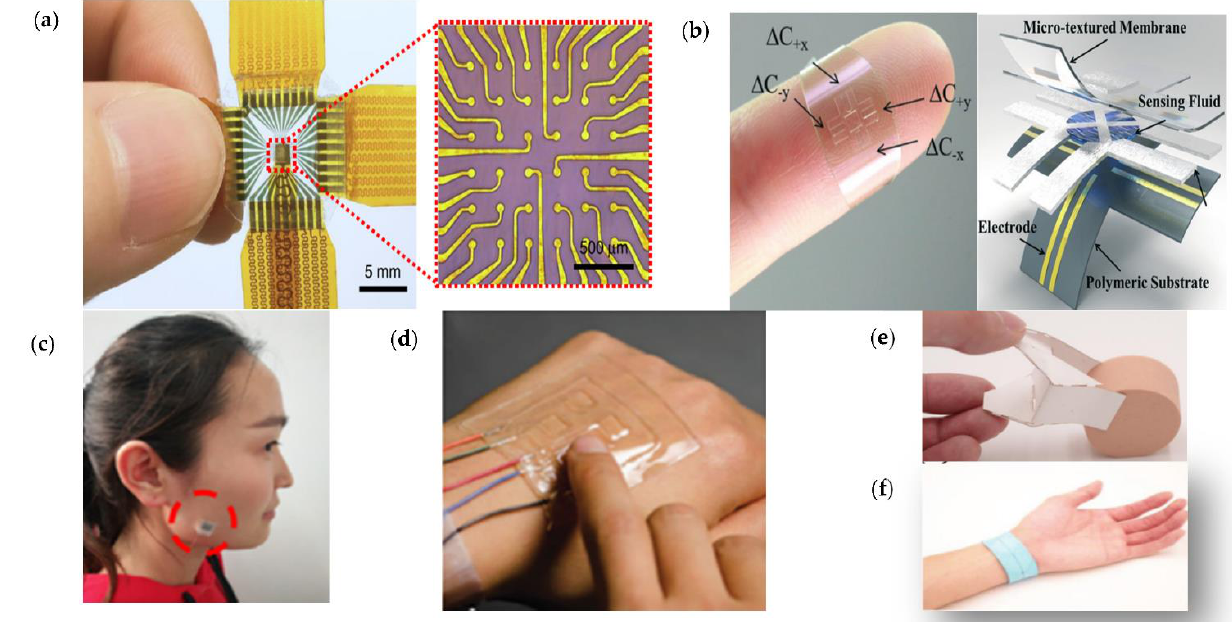
Figure 8. Several representative ionic sensors and their applications. ( a ) Flexible GIA-based micro-sensor arrays (left) with circular sensing pixels (Reprinted with permission from ref. [67]. Copyright 2020 The Authors); ( b ) A wearable sensor mounted on a fingertip (left) and 3D microfluidic sensing structure (right) for simultaneous tracking of the normal and shear force loads (Reprinted with permission from ref. [88]. Copyright 2014 Royal Society of Chemistry); ( c ) Pressure sensor mounted onto the cheek for real-time sensing of occlusion (Reprinted with permission from ref. [47]. Copyright 2019 American Chemical Society); ( d ) Pressure sensors (ionic skin) attached to the back of the hand (Reprinted with permission from ref. [100]. Copyright 2018 Macmillan Publishers Limited, part of Springer Nature); ( e ) Handwriting iontronic pressure sensing origami (Reprinted with permission from ref. [58]. Copyright 2019 American Chemical Society); ( f ) Wearable origami bracelet for pulse monitoring (Reprinted with permission from ref. [73]. Copyright 2019 WILEY-VCH Verlag GmbH & Co. KGaA, Weinheim,